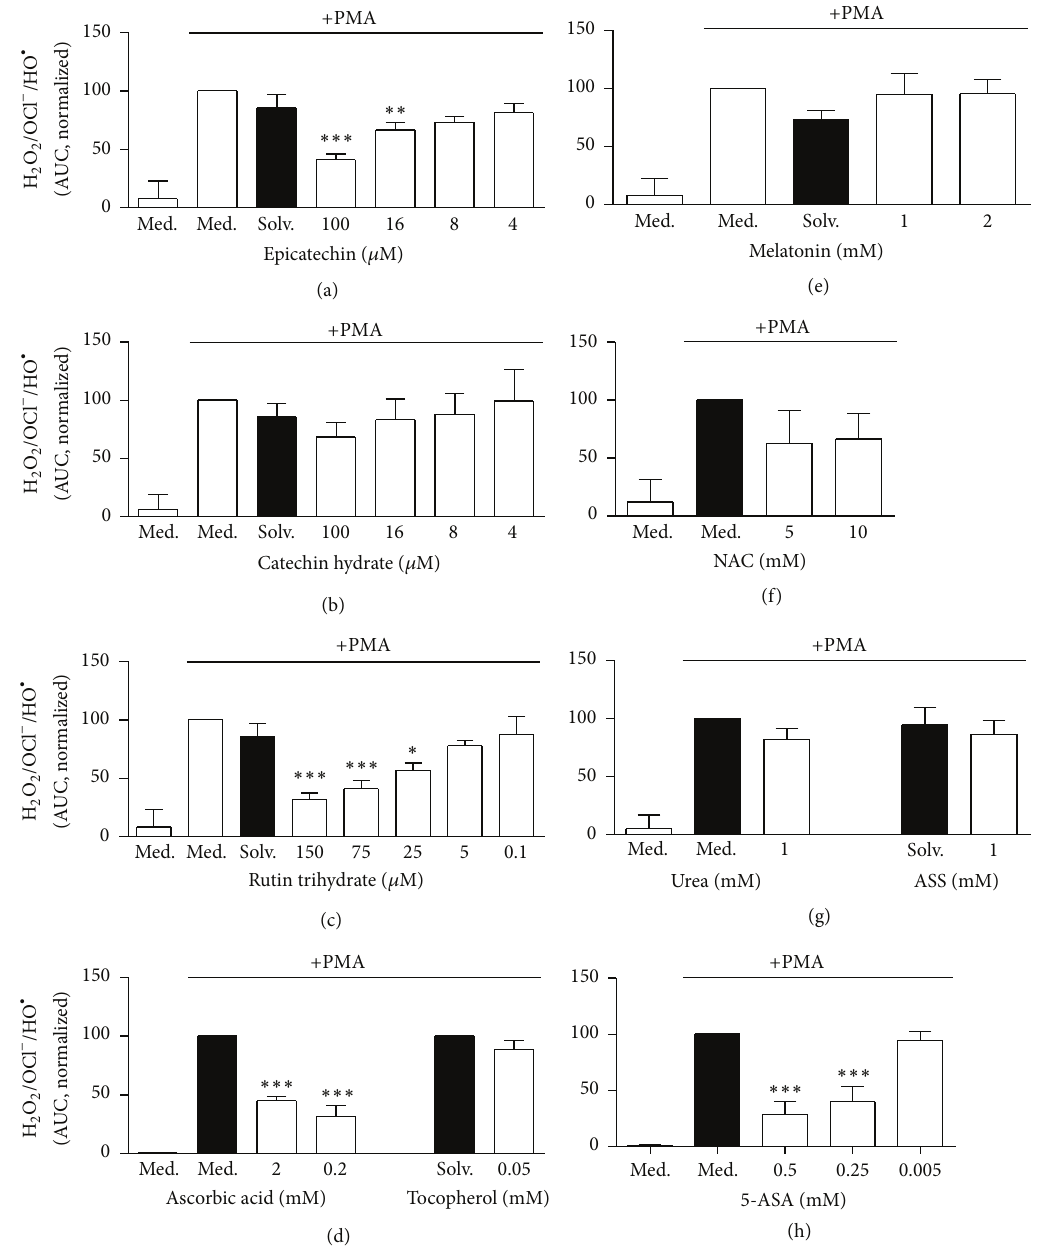
Figure 2: Influence of antioxidants on neutrophil ROS formation as measured by the luminol assay. Freshly isolated neutrophils were preincubated with or without antioxidants for 30min at 37 ∘ C. Following addition of luminol (0.06mM) and induction by 20 nM PMA, the kinetic of ROS formation was measured over a period of 1h at 37 ∘ C. ROS formation of (a) epicatechin, (b) catechin hydrate, (c) rutin trihydrate, (d) ascorbic acid and tocopherol, (e) melatonin, (f) N -acetyl-L-cysteine (NAC), (g) urea and acetylsalicylic acid (ASS), and (h) 5-aminosalicylic acid (5-ASA) was quantified by calculation of the area under the curve (AUC). Data were normalized to the sample with PMA-stimulated neutrophils without antioxidants (Med.). Data show mean ± SD from 3 ((d), (f), (g) (urea), (h)), 5 ((a), (c), (e), (g)